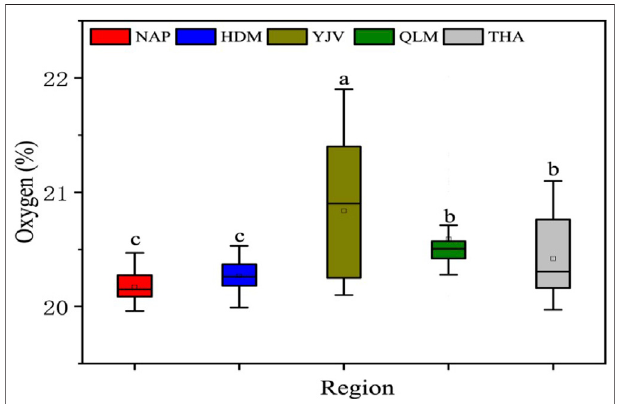
FIGURE 3 | The relative importance of altitude, climate, and vegetation factors to variation of atmospheric oxygen content among different regions. Percentage increasesin theMSE (mean squared error) ofvariables wereused toestimatetheimportanceofthesepredictors,andhigherMSE%values imply more important predictors. Signi fi cance levels are as follows: * p < 0.05 and ** p < 0.01. MSE, mean squared error; MMP, mean monthly precipitation; FVC, fractional vegetation cover; LOS, length of the growing season; MMT, mean monthly temperature; NPP, net primary productivity; LAI, leaf area index; WS, Wind Speed.